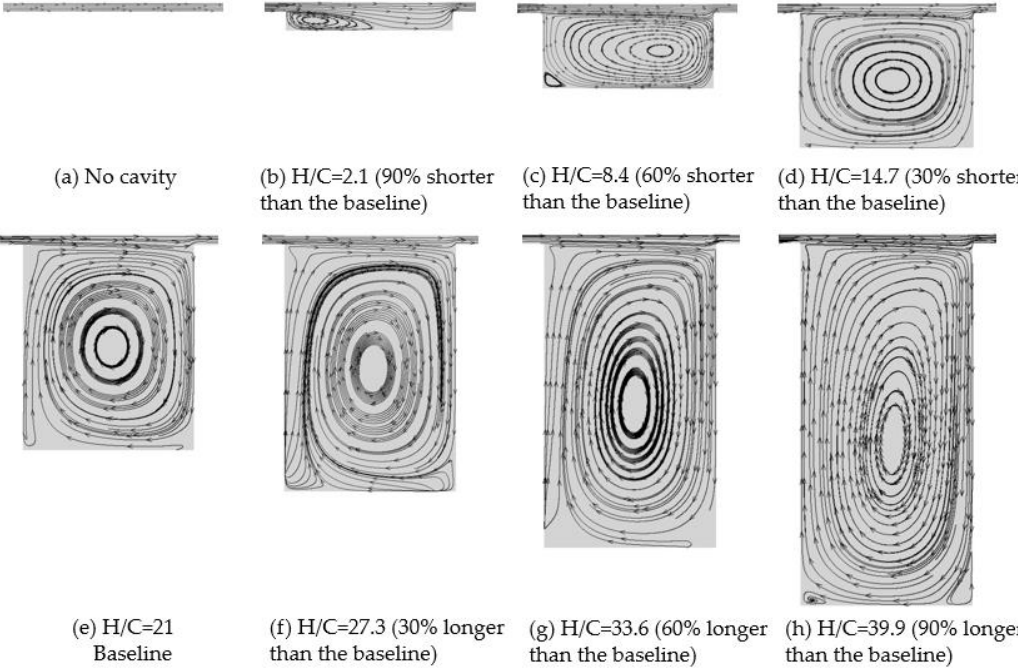
Figure 13. ( a – h ) The effect of changing the ratio of the tooth height to the clearance ( H/C ) on the streamlines of a straight‐ through labyrinth seal.